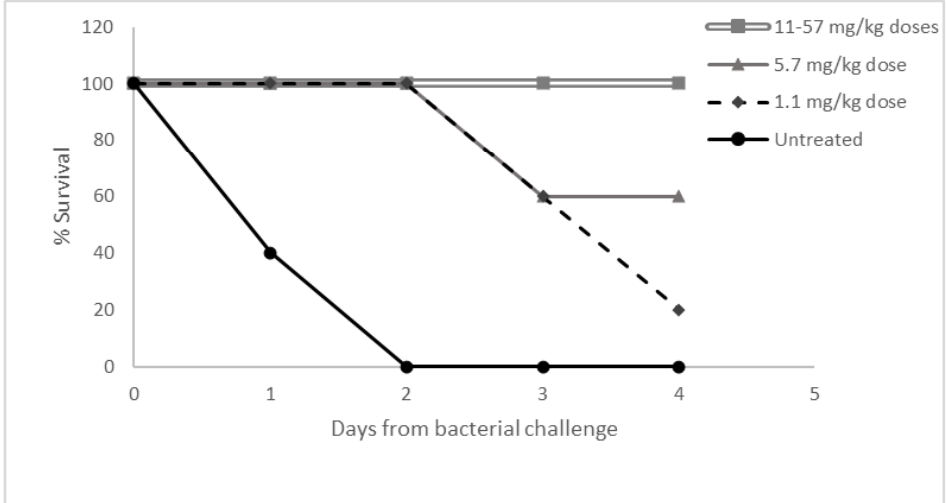
Figure 5. Dose response to Nano-mupirocin in a murine necrotizing fasciitis model.